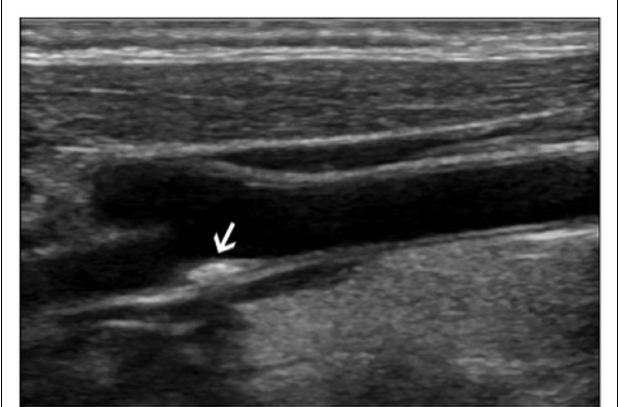
technique allows correct identification of eventual thoracic